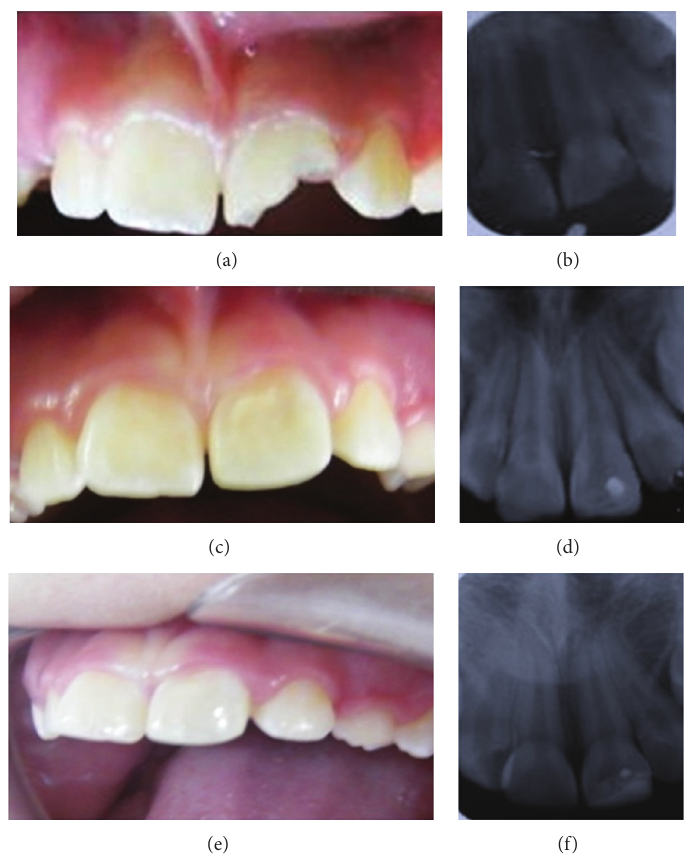
Figure 2: (a) Initial clinical image of patient 17 hours after trauma with complicated crown fracture in the maxillary left central incisor. (b) Initial radiograph showing loss of dental structure, complete root development, closed apices, and absence of root or alveolar bone fractures. (c) Resin reconstruction after treatment. (d) Posttreatment radiograph showing partial pulpotomy with resin reconstruction. (e-f) Clinical and radiographic images 25 months after treatment. Patient’s teeth were found to be vital; no pain to percussion or palpation, with functional